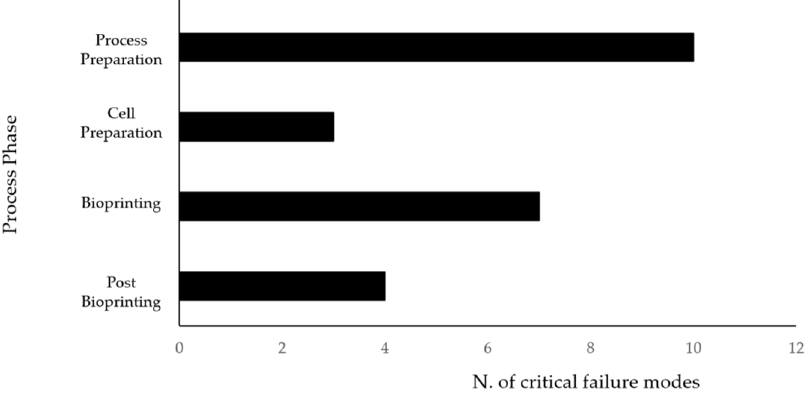
Figure 2. Schematic representation of critical failure modes (RPN > 100) occurrence for the different process phases: process preparation, cell preparation, bioprinting, post-bioprinting.